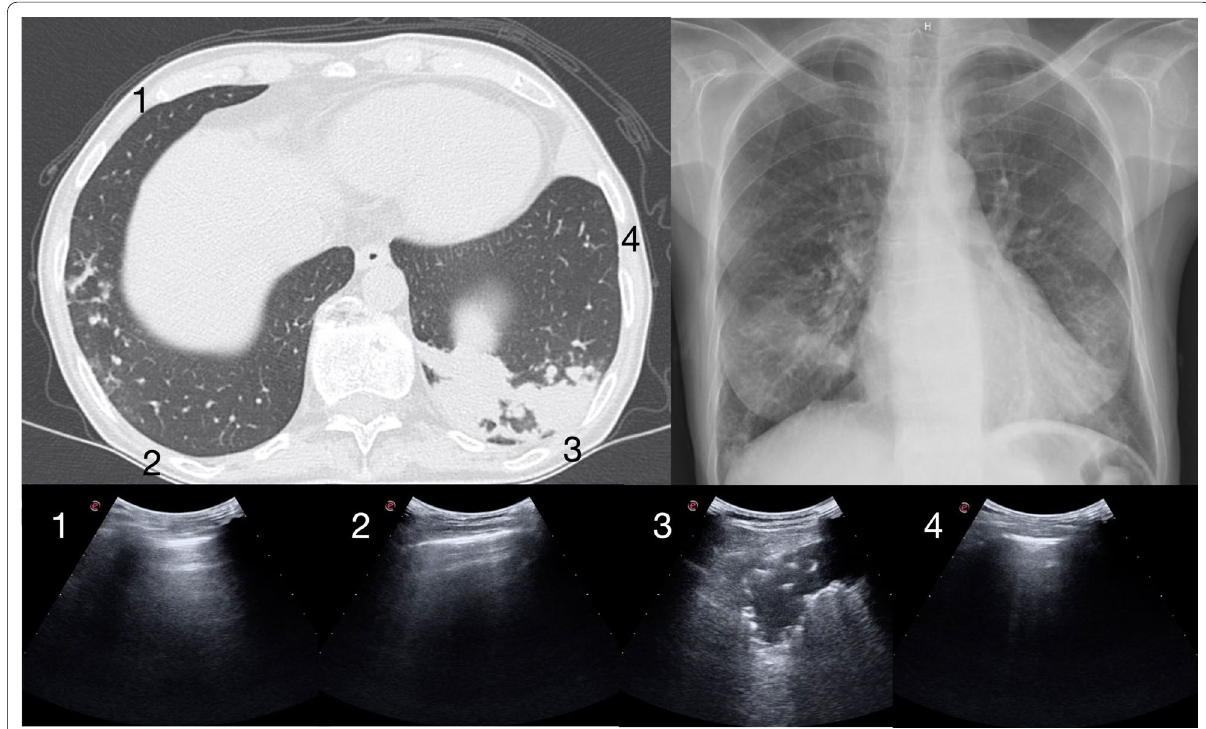
Fig. 5 The case of a 48-year-old woman with a history of HCV related chronic hepatitis, complaining of fever and cough for two weeks ( mild phenotype ). LUS and CXR were in disagreement. LUS showed an alternative pattern to COVID-19 pneumonia. One of the LUS scans reported in the bottom shows a large lobar isolated consolidation with dynamic air bronchograms (3). The other LUS scans show A-lines (1, 2, 4). CXR in the upper right panel was read typical of COVID-19 pneumonia due to bilateral reticular alterations and GGO. Corresponding CT scan in the upper left panel shows a large consolidation with air bronchograms without significant GGO alterations and was confirmed atypical appearance (bacterial pneumonia) The points numbered in the CT scan correspond to the 4 LUS scans. Viral RT-PCR was negative. The patient recovered after antibiotic treatment. LUS Lung Ultrasound, CXR Chest Radiography, COVID-19 Corona Virus Disease 2019, GGO Ground Glass Opacity, CT Computed Tomography, RT-PCR Reverse Transcriptase-Polymerase Chain